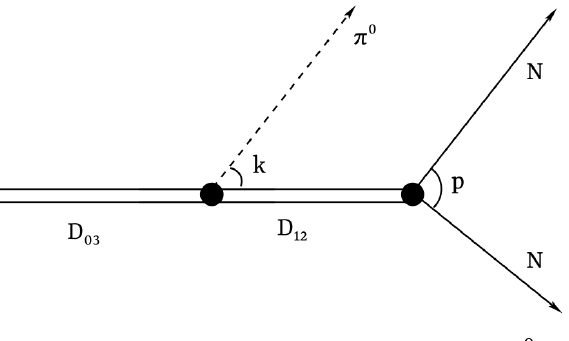
Figure 2: The mechanism of the decay D